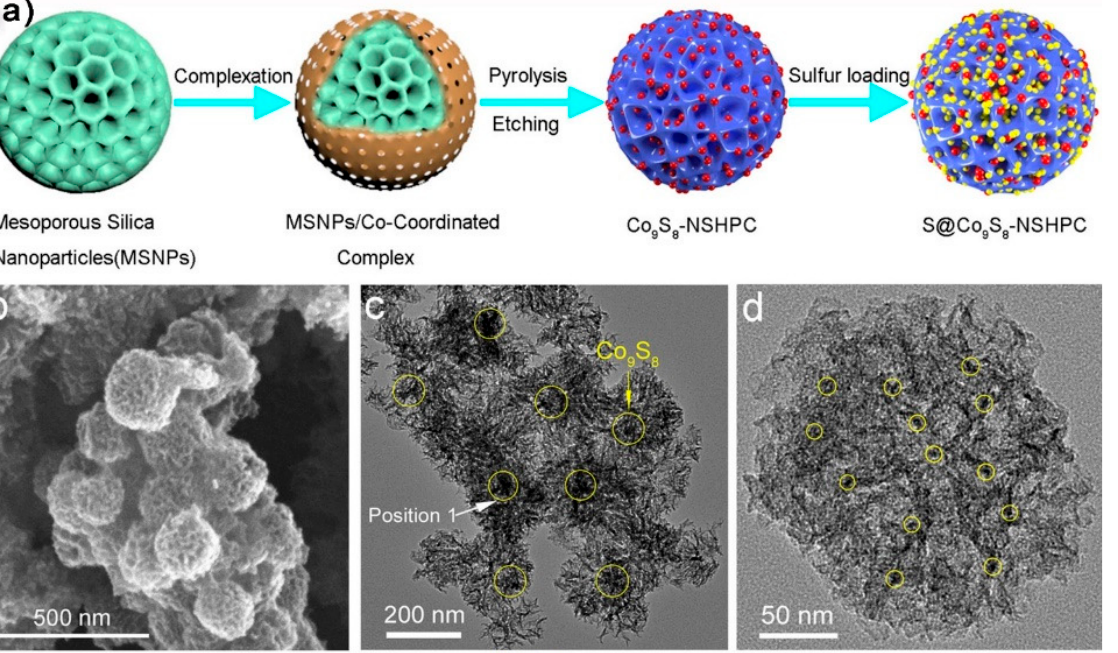
Figure 15. ( a ) Schematic diagram of the preparation of S@Co9S8-NSHPC, ( b ) SEM, ( c , d ) TEM images of Co 9 S 8 -NSHPC [106]. ( e ) Adsorption con fi gurations of Li 2 S 4 on MoS 2 − X and visual adsorption ex- periments on a Li 2 S 6 electrolytes after adding MoS 2 − X /HMC (yellow: S, blue: Mo, purple: Li, black circle: Mo–S bond) [107]. ( f ) Binding energies for Li x S n species on MoS 2 and CV curves of C@MoS 2 electrode with 0.1 M Li 2 S 6 [108]. ( g ) Discharge/charge curves and rate capabilities of S/NiS@C-HS. ( h ) Rate capabilities of S/NiS@C-HS at 0.2 C. [109]. 3.2.6. Metal Nitrides Composite MCBM Metal nitrides are another polar substance with excellent electrical conductivity. Metal nitrides and mesoporous C composites are still in the earliest stages of development for LSBs, because of their complex synthesis process.